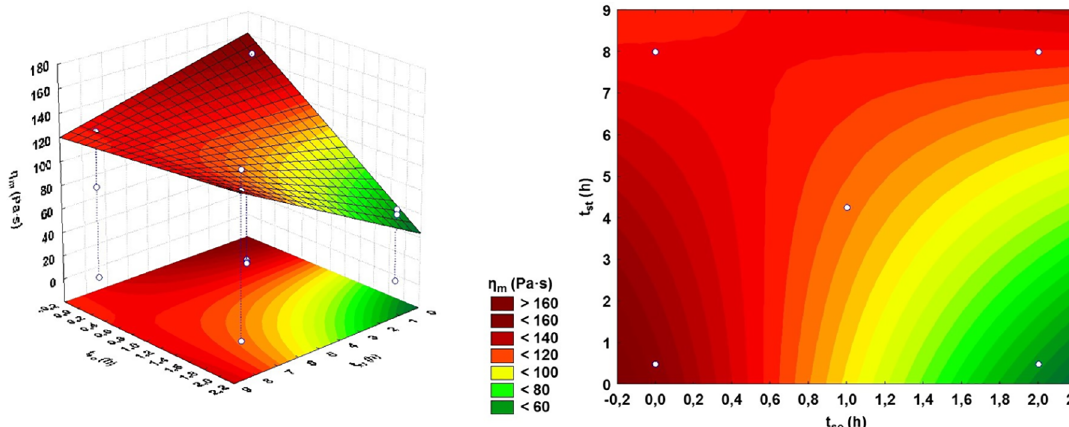
) with C = 20% in volume (silica concentration) and S m s